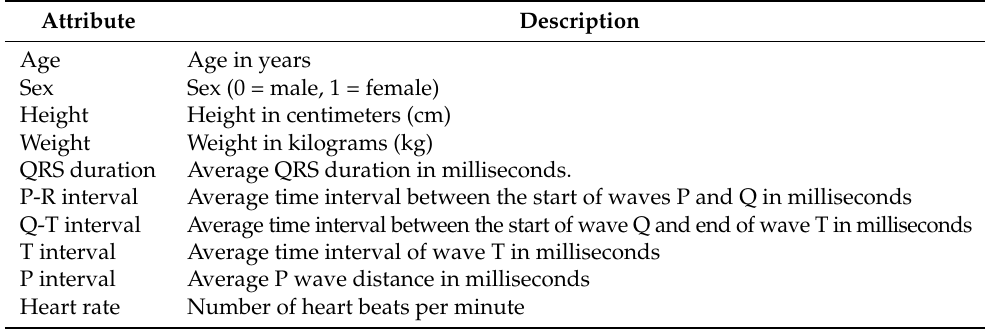
Table 2. The UCI database attribute information